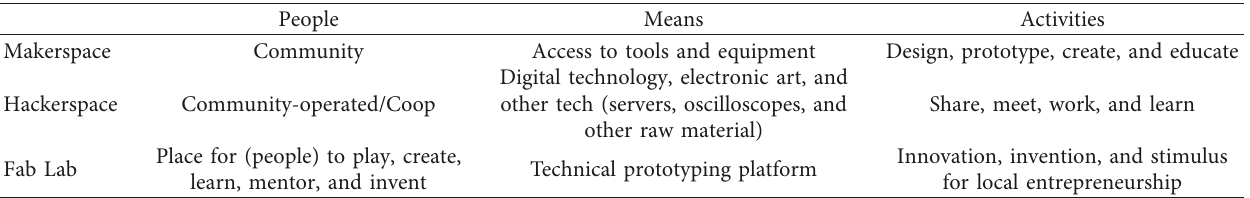
Table 1: A breakdown of the definitions of Making forwarded by established initiatives within the framework of people, means, and